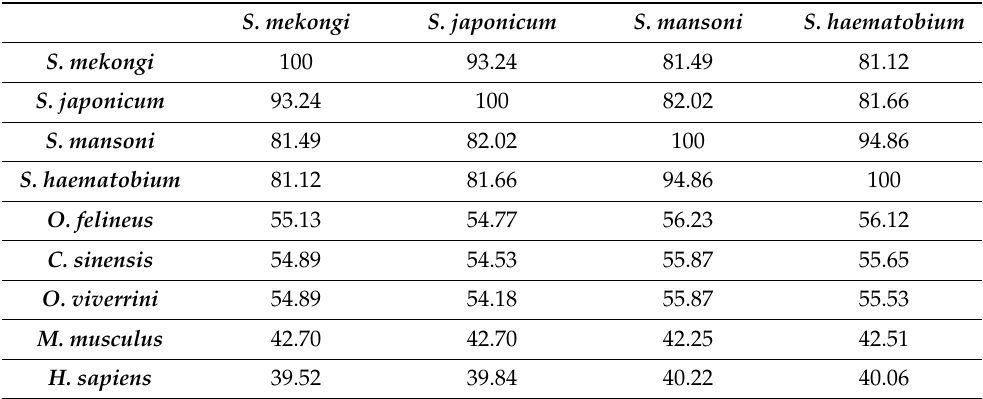
Table 4. Percent identity matrix of S. mekongi , S. japonicum , S. mansoni , S. haematobium , M. musculus and Homo sapiens ubiquitin thioesterase